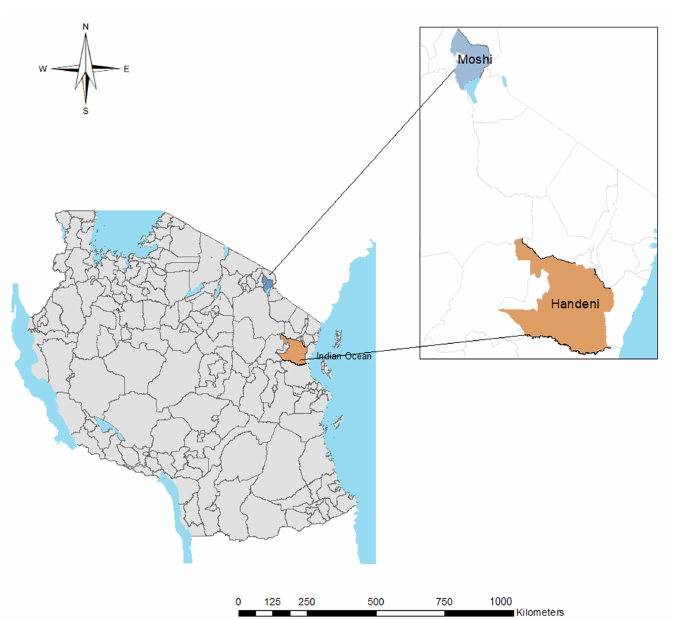
Figure 1. Map of Tanzania showing study sites (created by ArcGIS software v10.3, ESRI, Redlands, CA, USA).